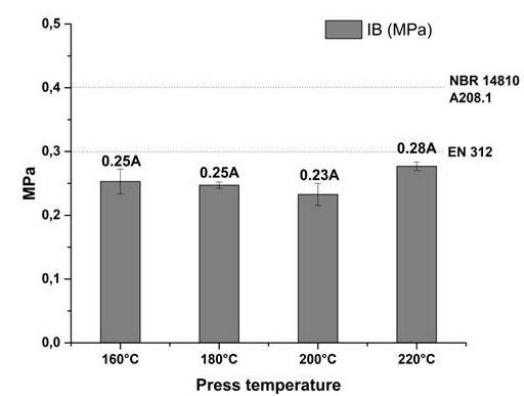
Figure 7. Internal bonding (IB) for particleboard panels produced with sugarcane bagasse and plastic bag particles at different pressing temperatures. * Averages followed by similar letter did not differ statistically by the Scott-Knott test at 5% significance